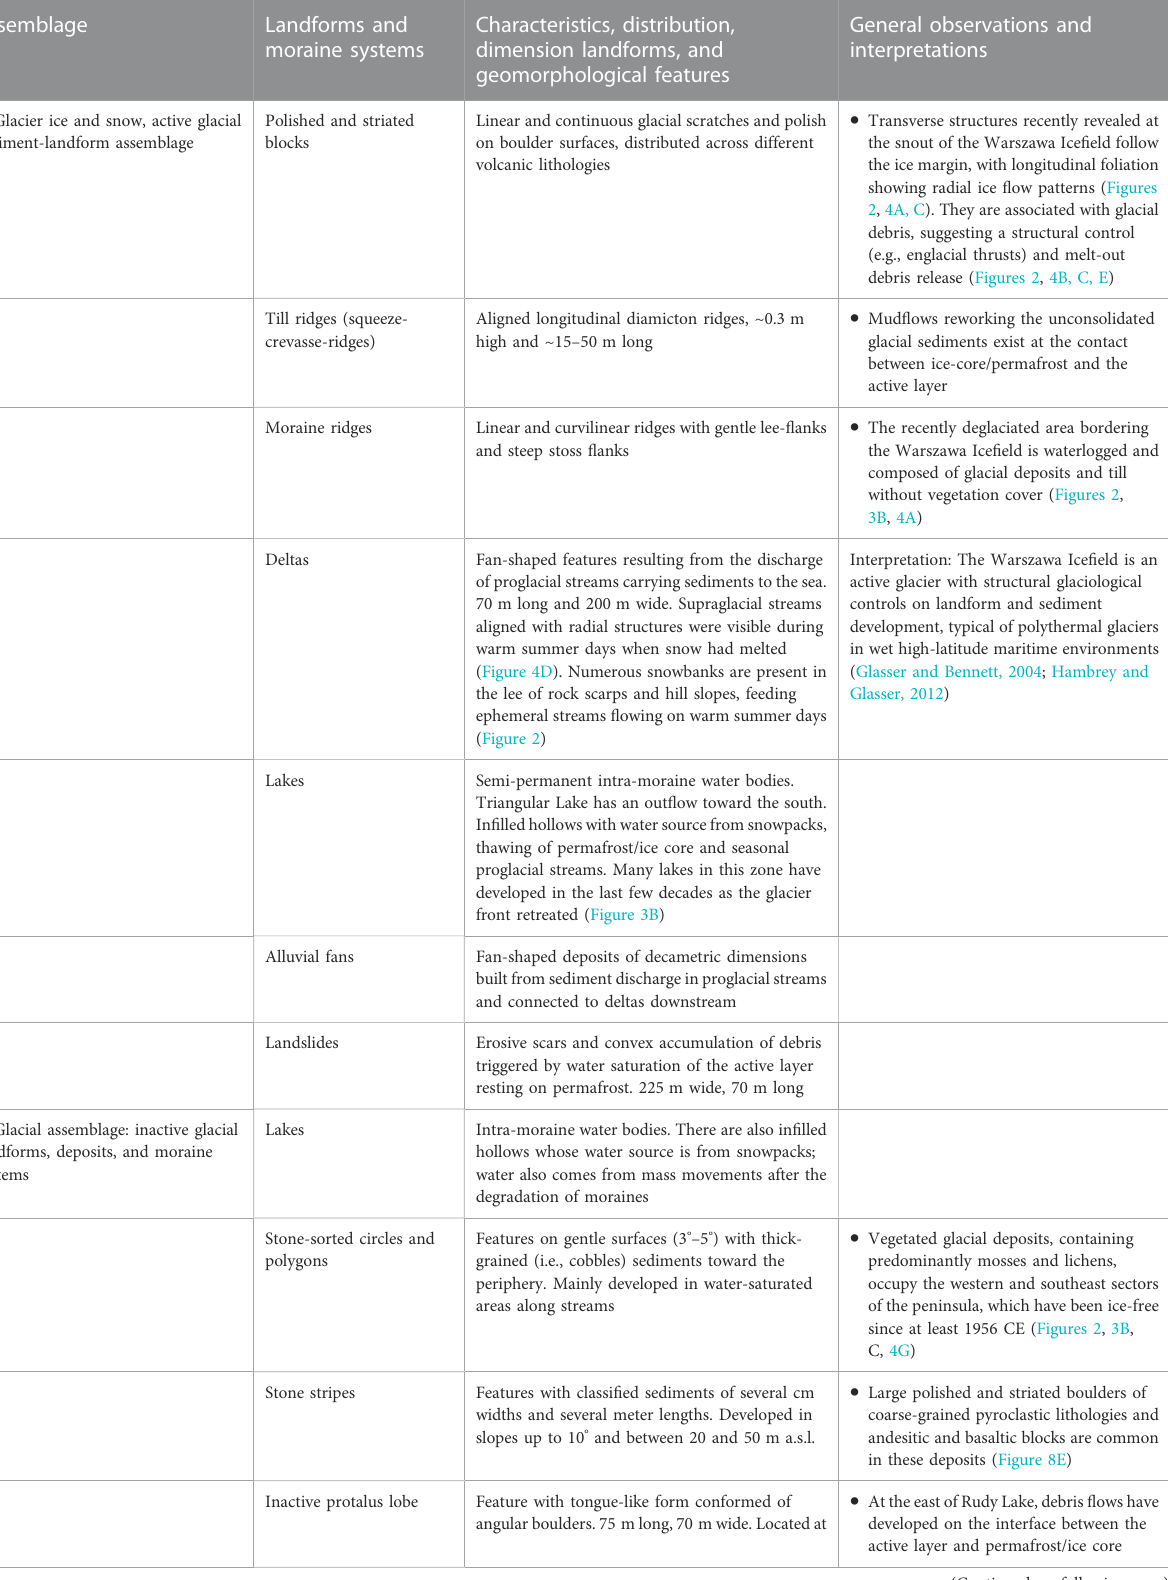
TABLE 1 Summary descriptions of landform assemblages and local geomorphological units identi fi ed in this study on Potter Peninsula.